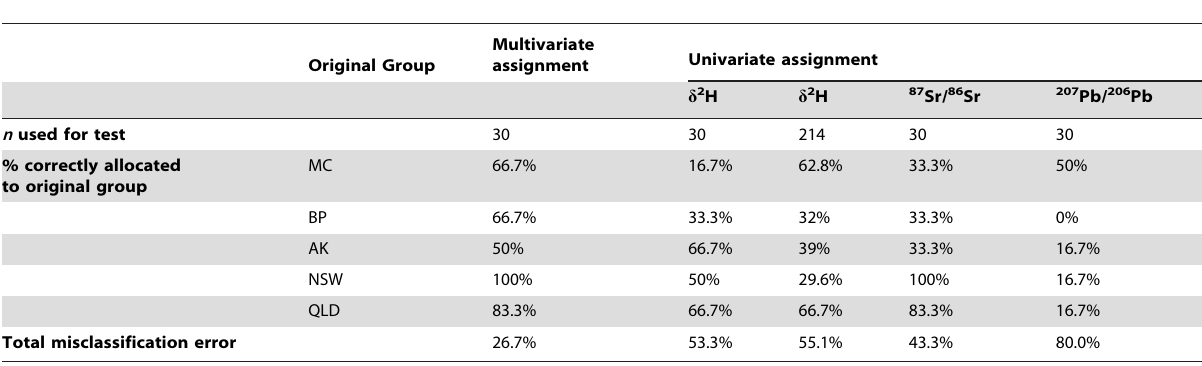
Table 3. A comparison of the regional discrimation achieved by multivariate and univariate analyses.